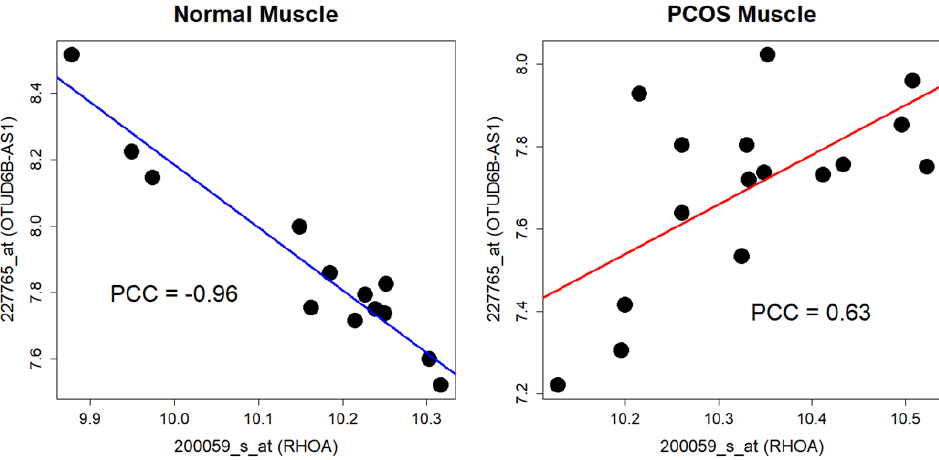
Figure 5. Differential coexpression of RHOA and OTUD6B-AS1 in GSE6798. A negative correlation between the genes is observed in the control group, but the correlation turns positive in PCOS group, respectively. PCOS—polycystic ovarian syndrome; PCC—Pearson’s correlation coefficient. Table 2. Top 10 Significant results of differentially coexpressed genes in meta-analysis.